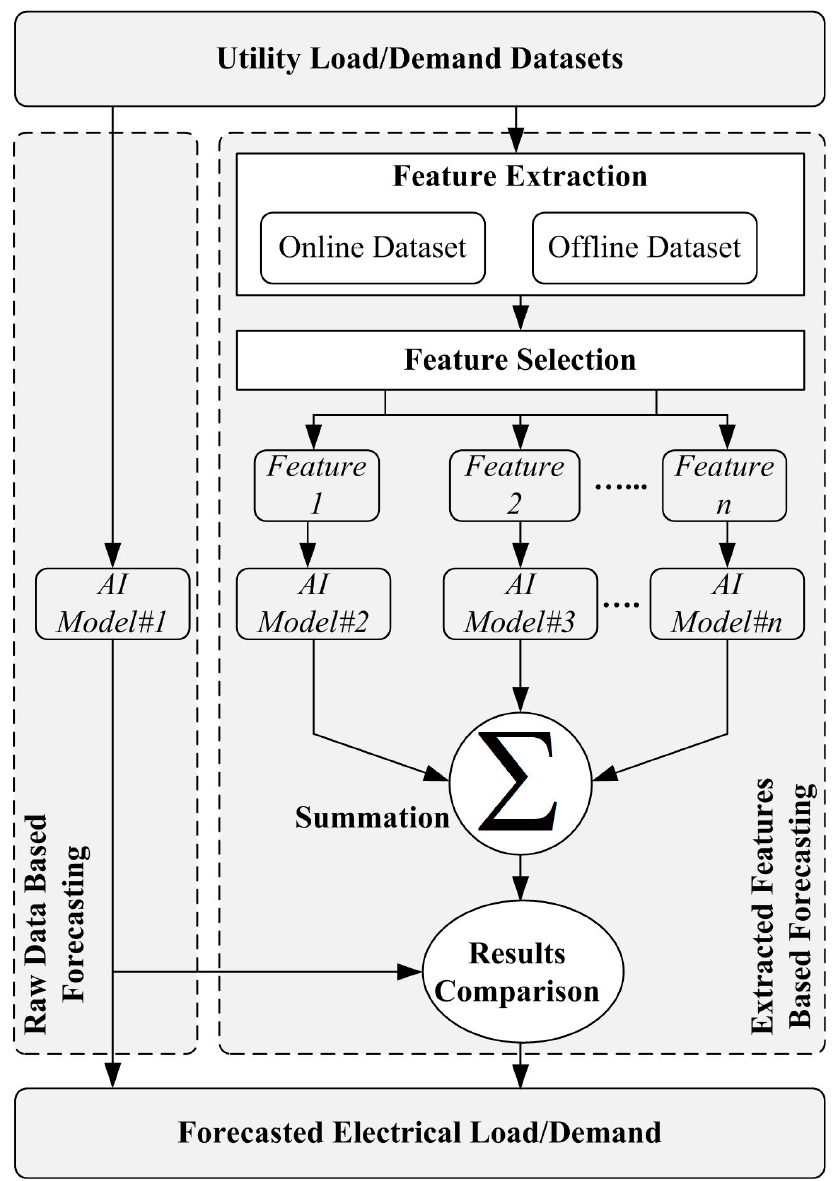
Figure 1. Proposed approach for load forecasting.